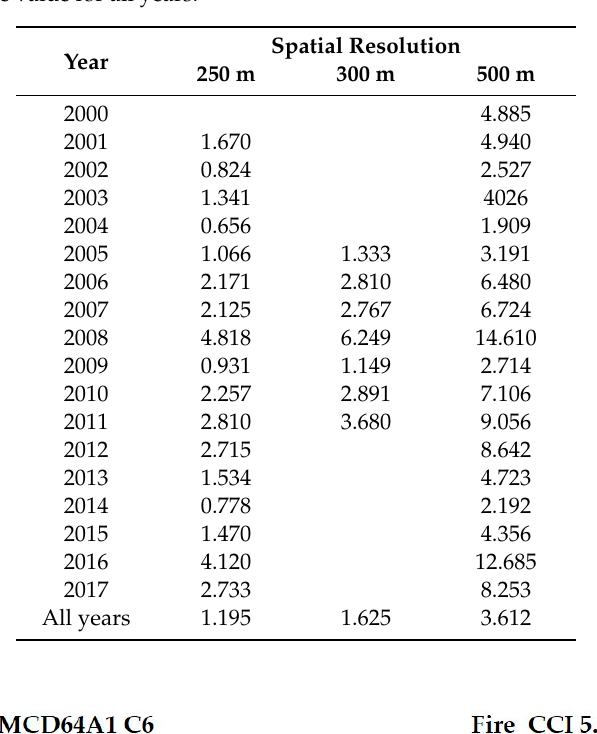
Table 5. Areas (× 10 − 3 ) enclosed by the annual Pareto Boundaries (AUPB) at different resolutions and the weighted average value for all years.